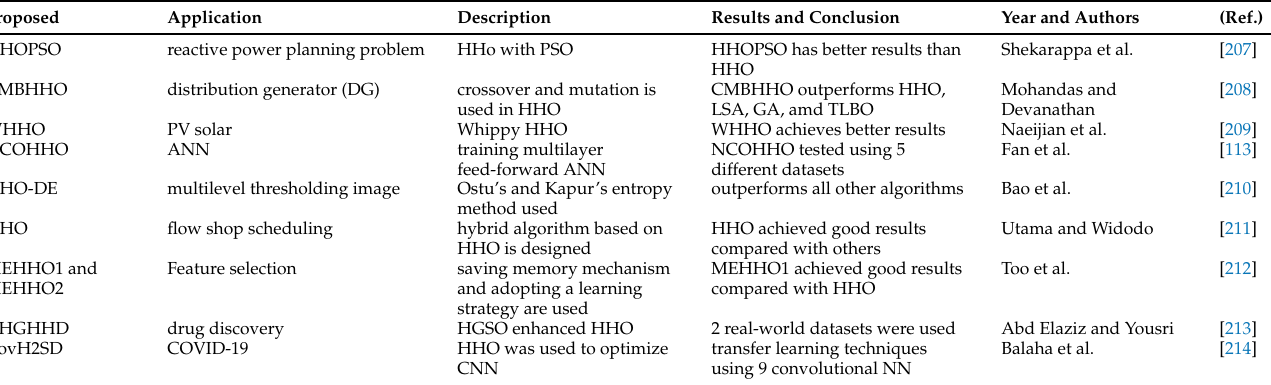
Table 9. The applications of HHO